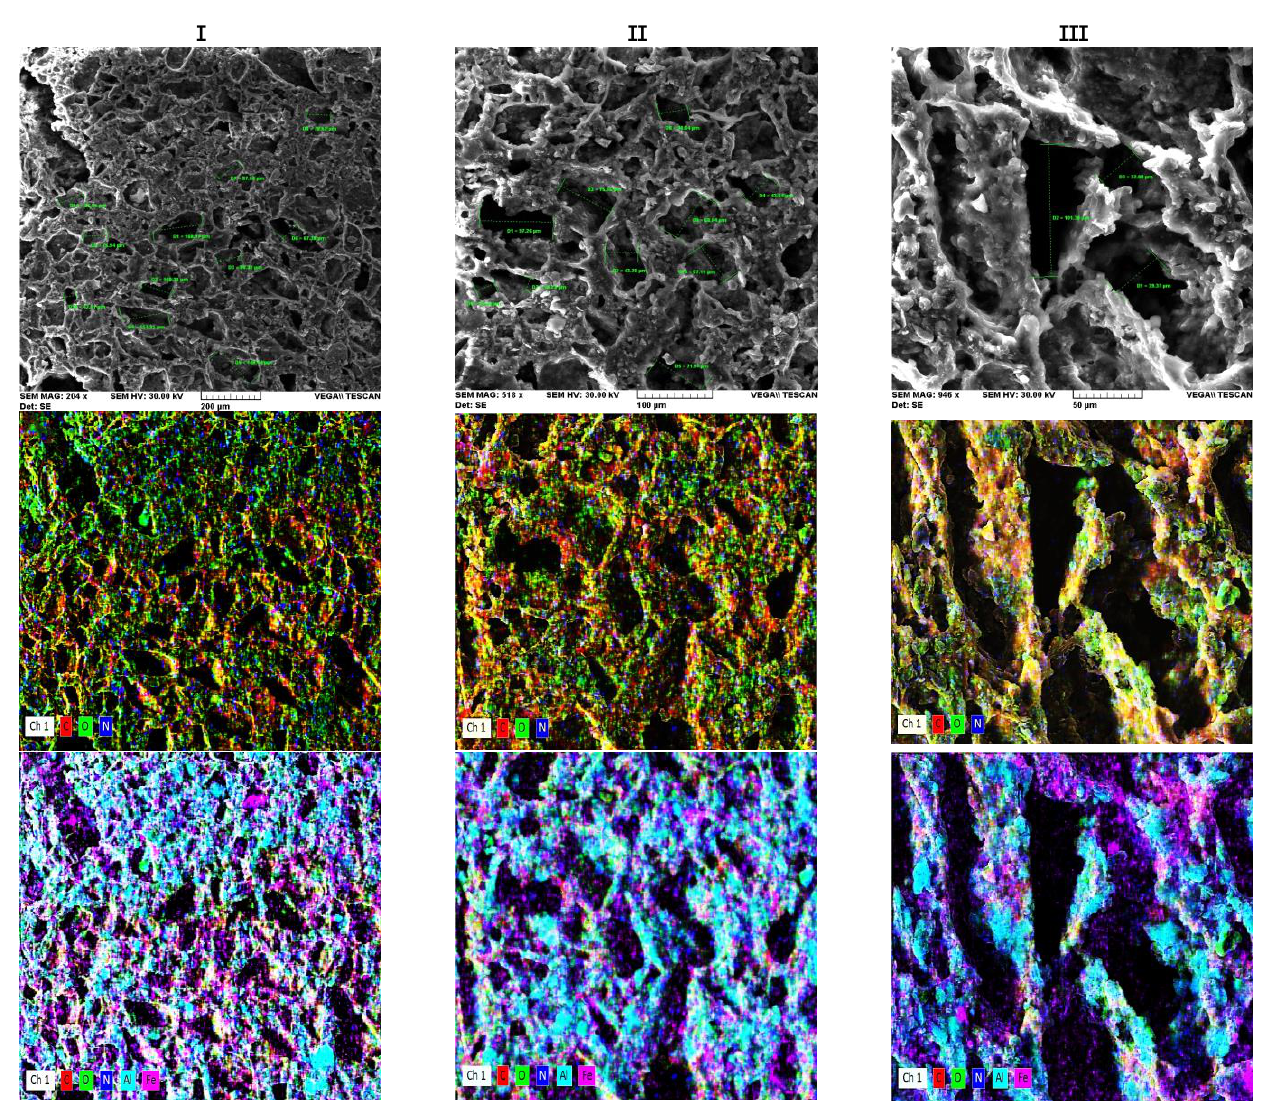
Figure 11. SEM and EDX analysis of the porous ECP_D5 formulation (after oxidizer extraction) at different scales: ( I ) 200 μm ; ( II ) 100 μm ; ( III ) 50 μm .